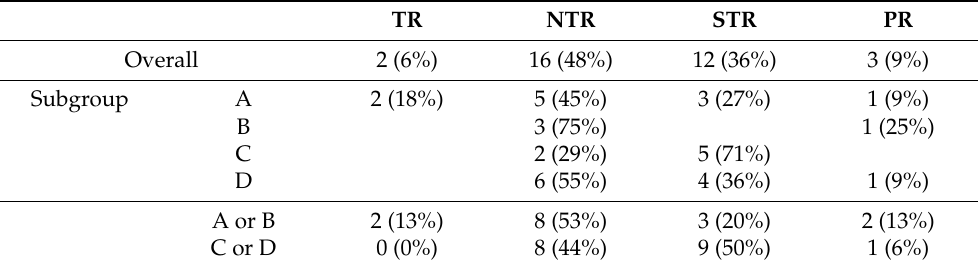
Table 1. Results of tumor resection extent. Total tumor resection (TR) or near total resection (NTR) was achieved in 18 of 33 patients (55%). In class A or B patients, TR or NTR was achieved in 10 of 15 patients (67%), whereas NTR was achieved in eight of 18 patients (44%) in class C or D. In contrast, relatively higher subtotal resection (STR) or partial resection (PR) rates were observed in class C or D